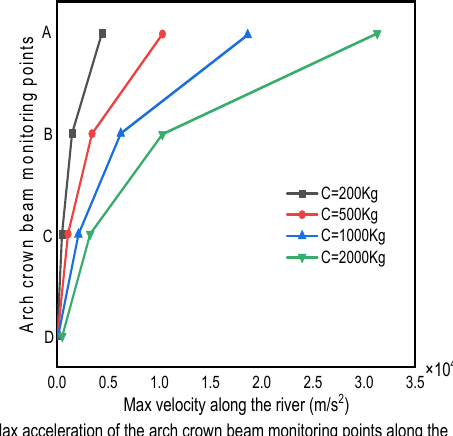
Max velocity along the river (m/s 2 ) (f) Max acceleration of the arch crown beam monitoring points along the river Figure 12. Dynamic response of monitoring points with different TNT amounts. As shown in Figure 12, as the explosive equivalent weight increases, so do the max- imum values of displacement, velocity, and acceleration at each monitoring point. The initiation center is located at the height of 275 m dams of the arch crown beam. For the monitoring points on the dam top, the dynamic response of the monitoring points at the arch crown beam is the most intense. The closer the monitoring point is to the arch end, the farther it is from the initiation center, and the less the dynamic response is. The dynamic response of the monitoring points on the arch crown cantilever is most intense at the top